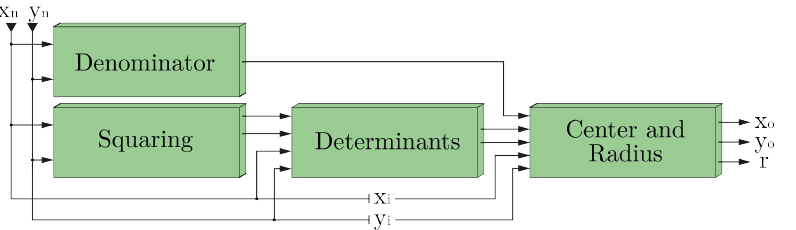
Figure 5. Block diagram for genotype to phenotype